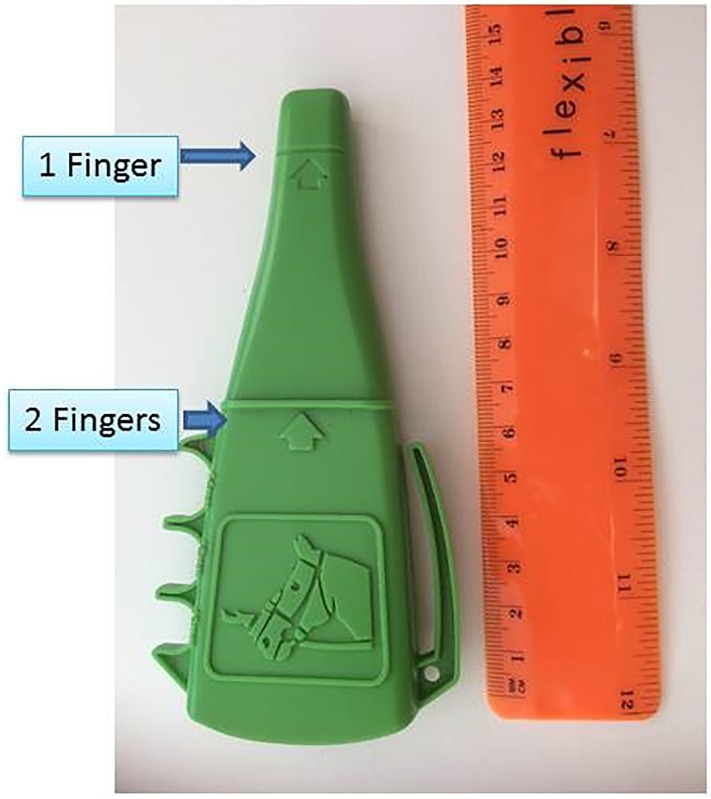
ISES Taper Gauge designed to allow measurement of approximate noseband tightness.At standard recommended noseband tightness, the taper gauge can be easily inserted beneath the noseband as far as the 2 Finger notch.